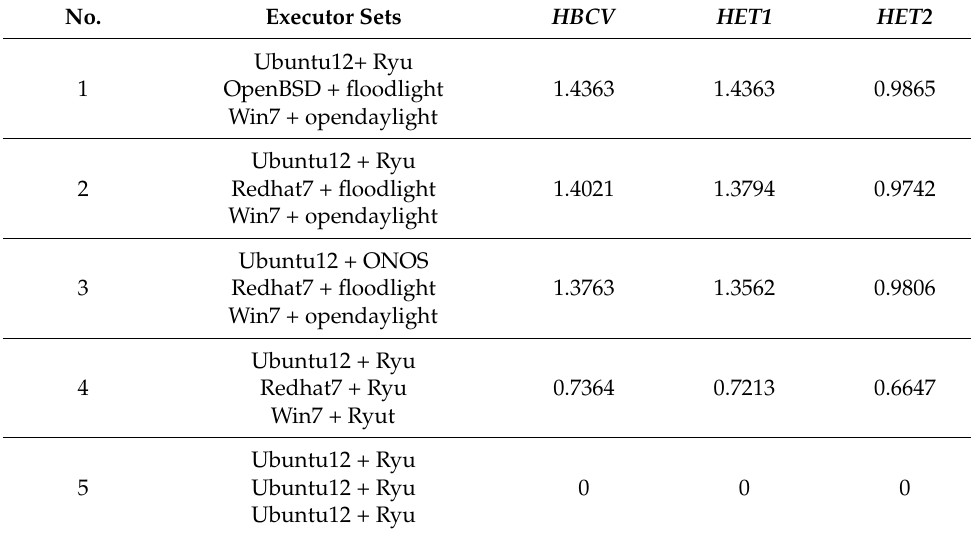
Table 1. Comparison of heterogeneous quantification results of mimic control